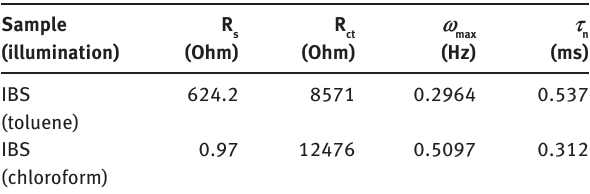
Table 1: EIS results of IBS composite thin films indicating values of R , R , w and t s ct max n